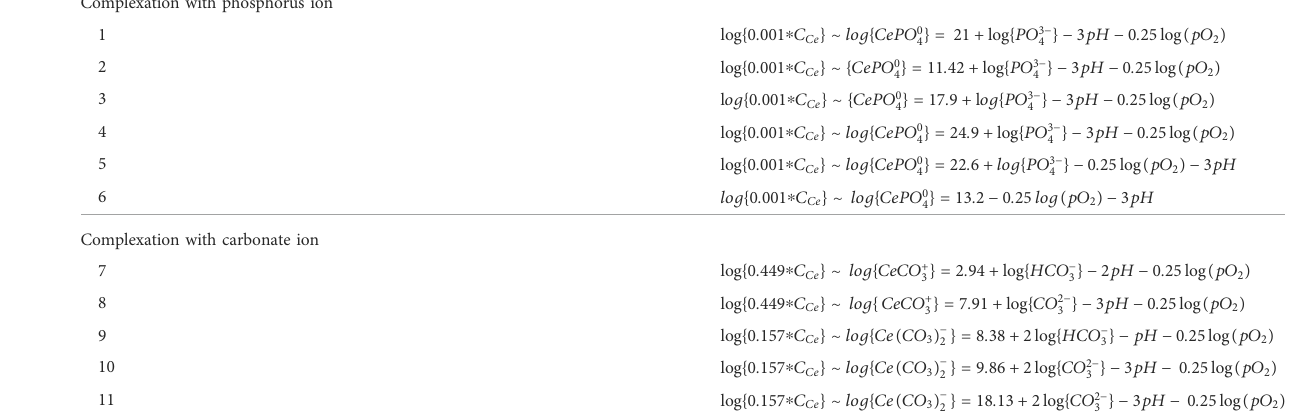
TABLE 3 Derive equations for Ce oxidation model. Model number Equation Complexation with phosphorus